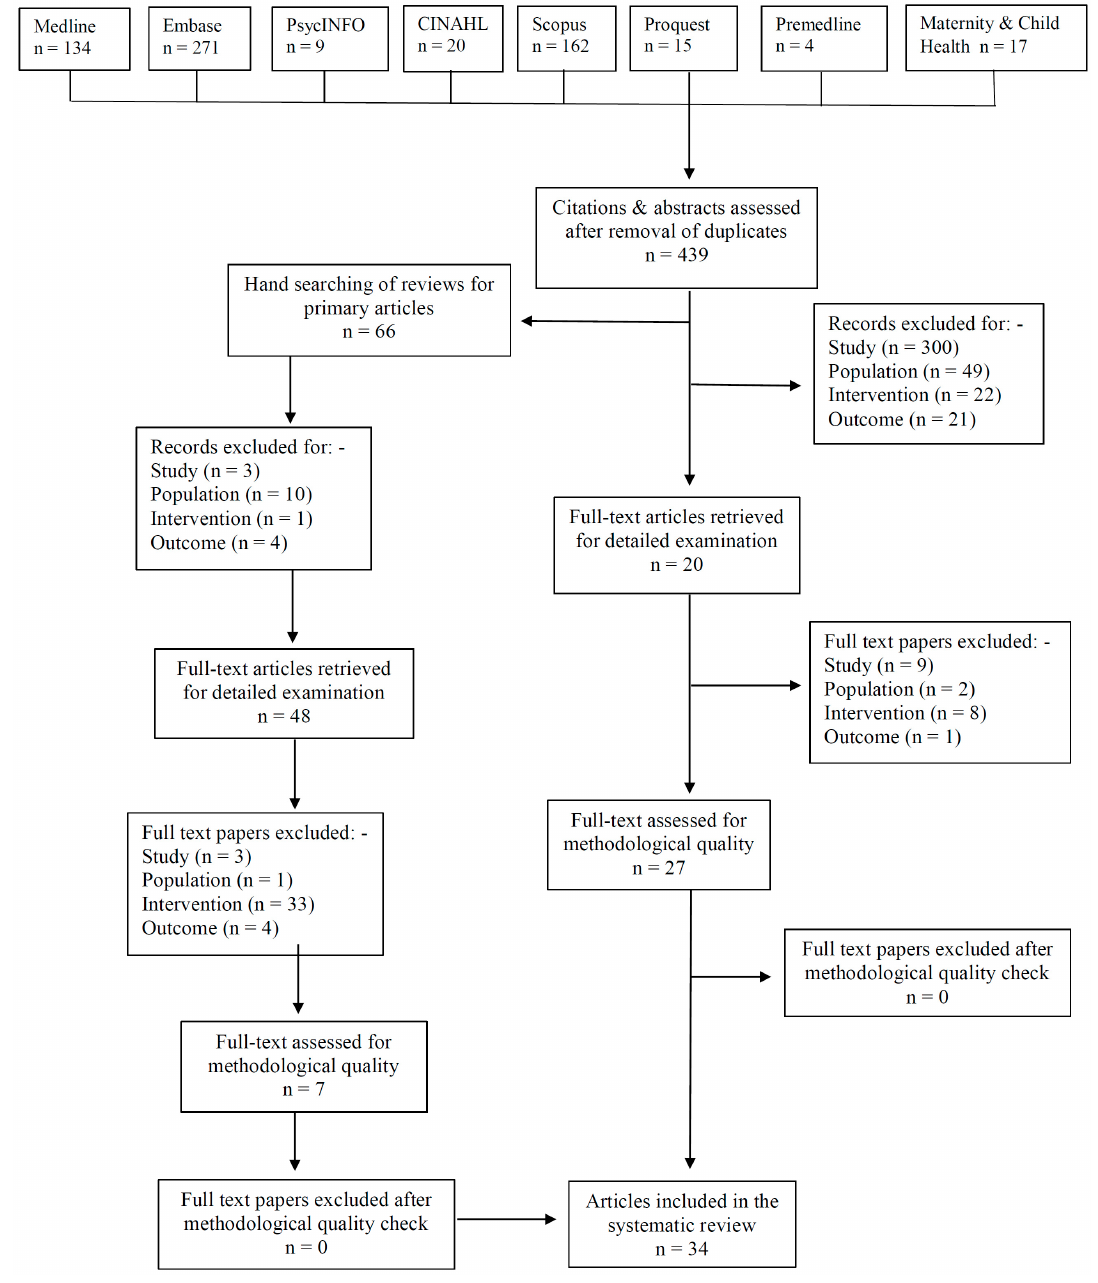
Figure 1. Flow chart for study selection process.